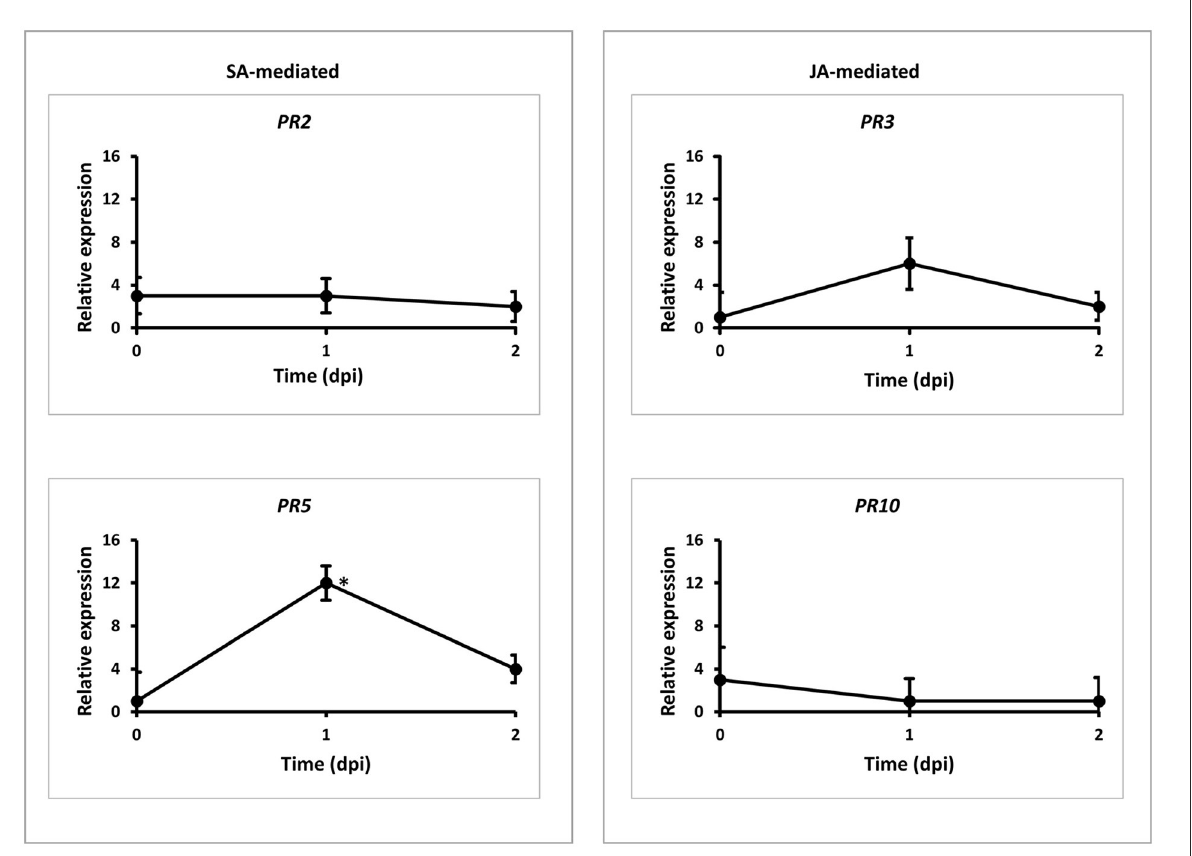
FIGURE5 Expressions of pathogen related (PR) genes responding to Pgt (race TMLKC) in the wild-type and mutant wheat lines. Wild-type Cadenza and mutant L683F-MYC4-1BL were inoculated with the Pgt pathogen at 2-leaf stage. RNA samples were extracted from the leaf samples collected at three time points. Real-time PCR was used to quantify transcript abundances of the four PR genes. Expression of PR genes at each time point was expressed in the mutant relative to the level in the wild-type. * denote statistical significance at the P ≤ 0.05 levels compared between wildtype and mutant at each time point. Error bars represent standard deviation computedas the square root of pooled variance between